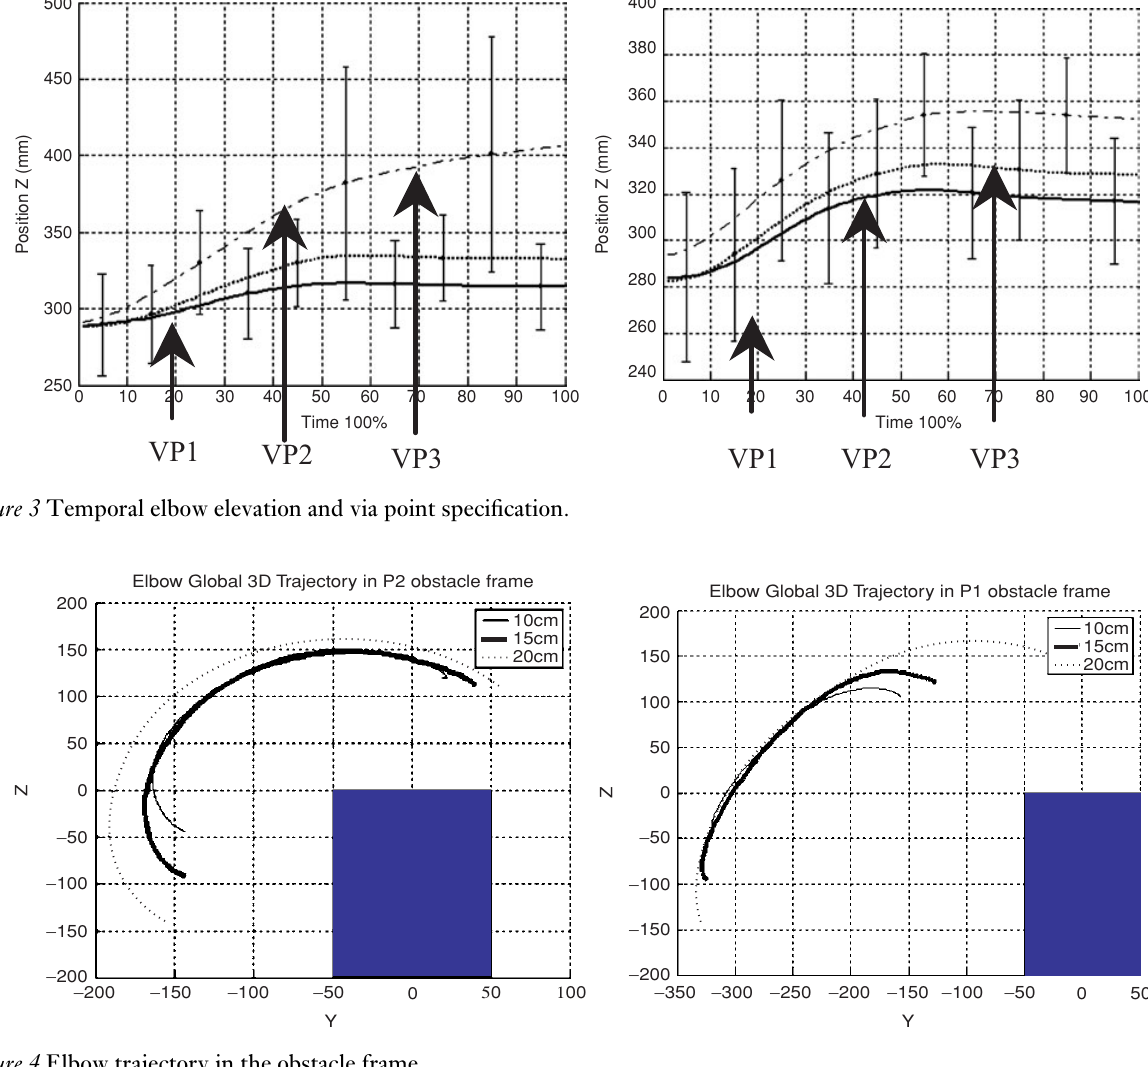
Figure 4 Elbow trajectory in the obstacle